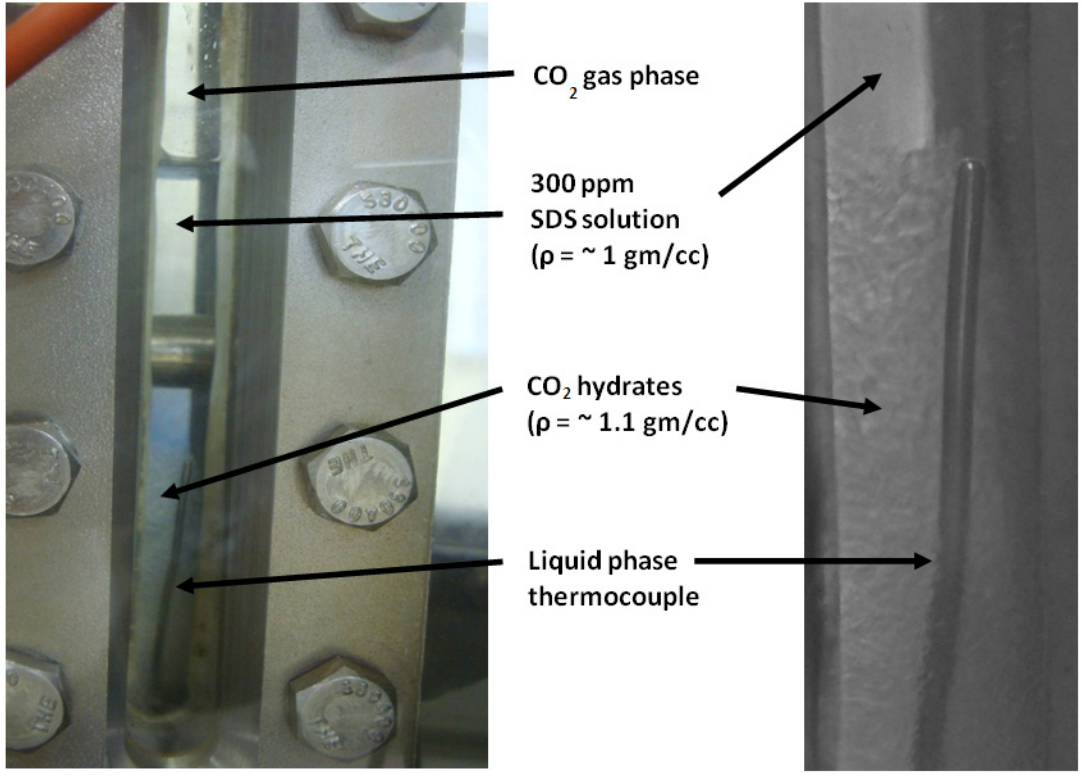
Figure 4. CO Hydrates formed during Run 1. The run conditions are shown in Figure 3. 2 The image on the right is a close up of the hydrates shown in the reactor on the left.